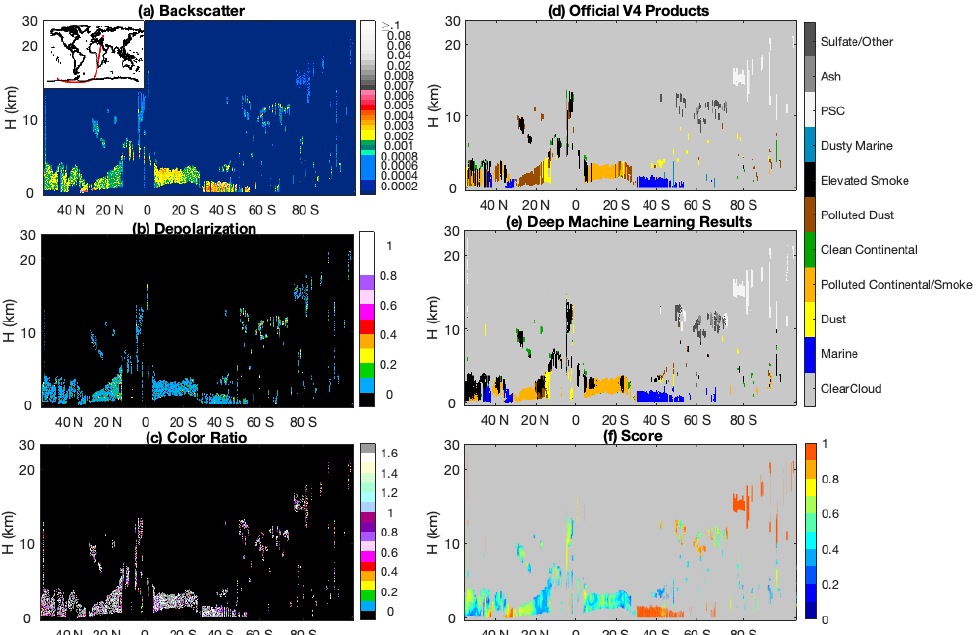
Figure 5. The same information is shown as in Figure 3 except for nighttime data acquired on 19 June 2011, starting at 23:53:12 UTC. ( a – c ) The 532 nm backscatter intensity, volume depolarization, and attenuated total backscatter color ratio measurements, respectively. The CALIPSO ground track is overlaid in the upper-left corner of panel ( a ). ( d ) The aerosol classifications reported by the CALIOP operational scene classification algorithms. ( e ) The classifications determined by the trained convolutional neural network. ( f ) The CNN classification scores.